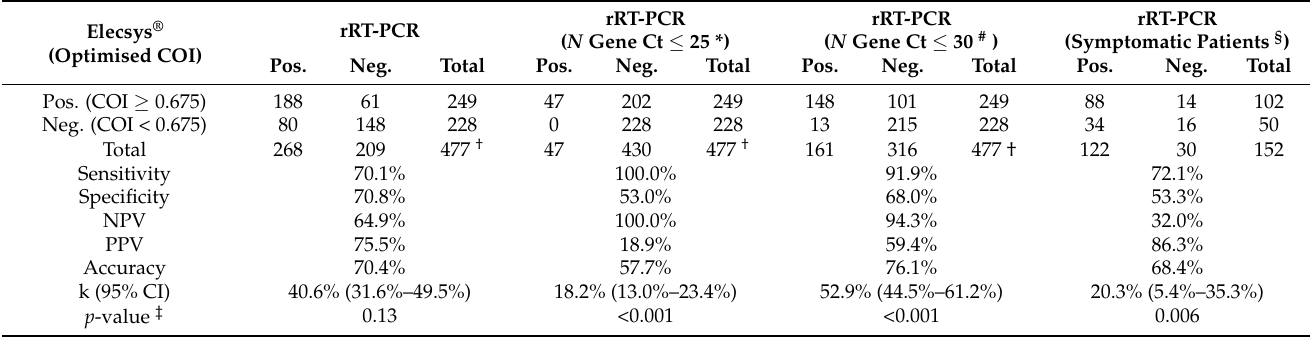
Table 6. Results of reference method (rRT-PCR) and tested method (Elecsys ® SARS-CoV-2 Antigen assay) using an optimised cut-off value.